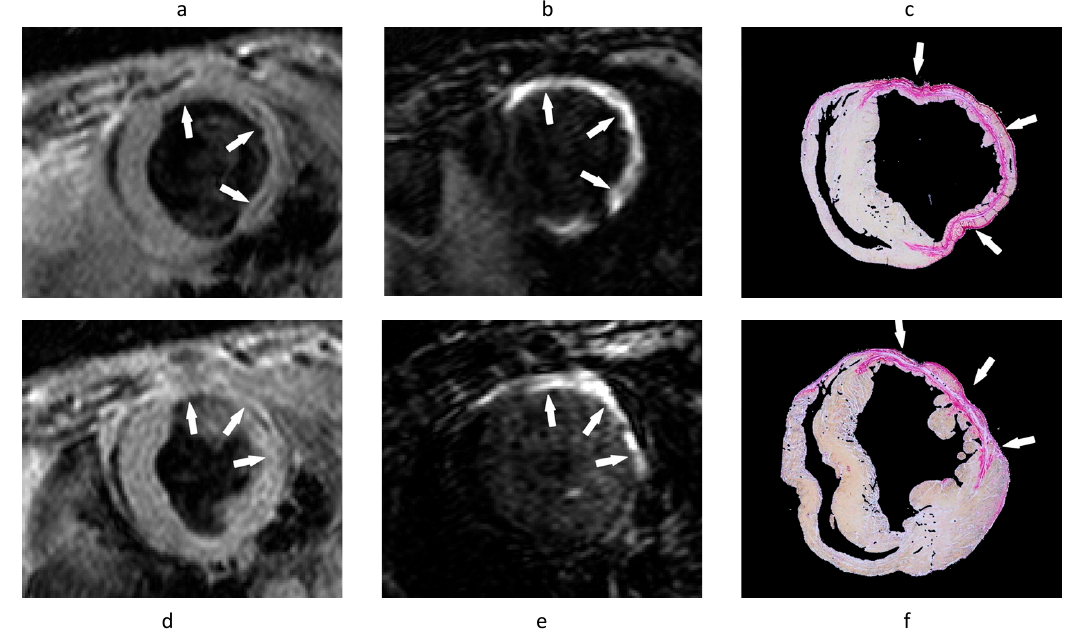
Figure 15. ( a , b , d , e ) Gradient-echo IR MR images and ( c , f ) corresponding picrosirius red–stained histologic sections of the LV. Arrows point to area of scarring. ( a , d ) Standard anatomic MR images acquired by using a double IR gradient-echo sequence (8.0 / 3.7 / R-R interval). ( b , e ) Regions of contrast enhancement on midventricular short-axis MR images (7.1 / 3.0 / 430) of the LV at two section locations obtained 40 min after EP-3533 injection correlate closely with ( c , f ) photomicrographs of picrosirius red–stained tissue sections shown at nine times their original size. LV—left ventricle. Reproduced with permission from Helm et al., 2008 [107].